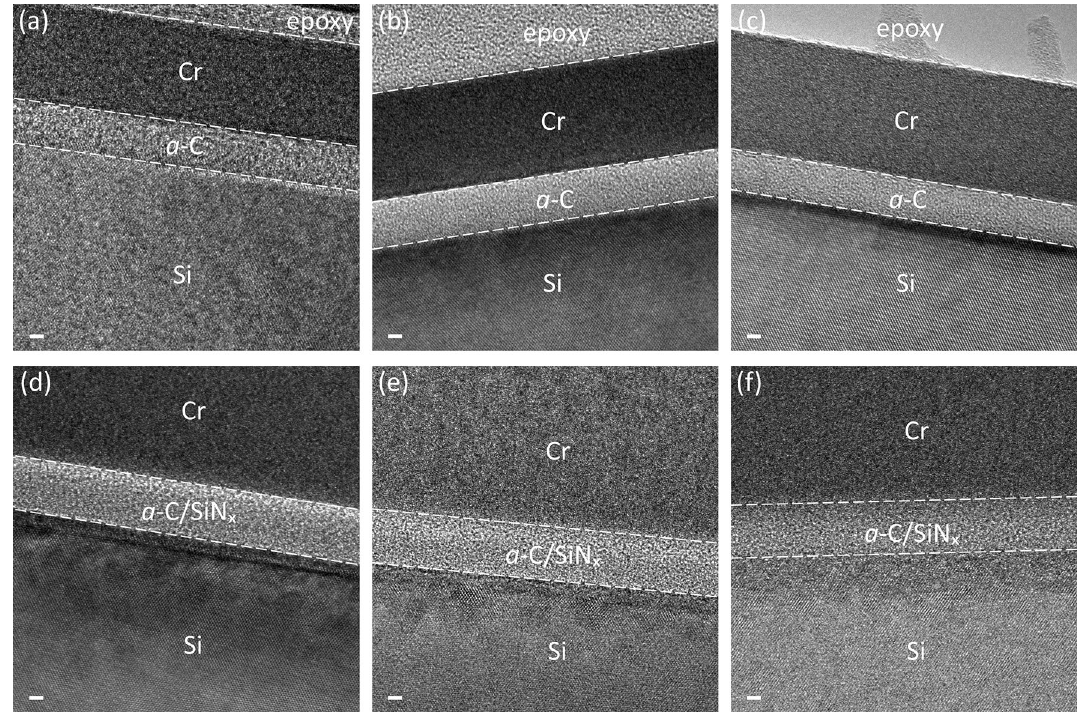
Figure 1. Cross-sectional TEM images of ( a – c ) a -C/Si and ( d – f ) a -C/SiN x /Si stacks obtained before ( a , d ) and after RTA at 250 °C in Ar atmosphere for ( b , e ) 30 min and ( c , f ) 90 min. All scale bars are equal to 2